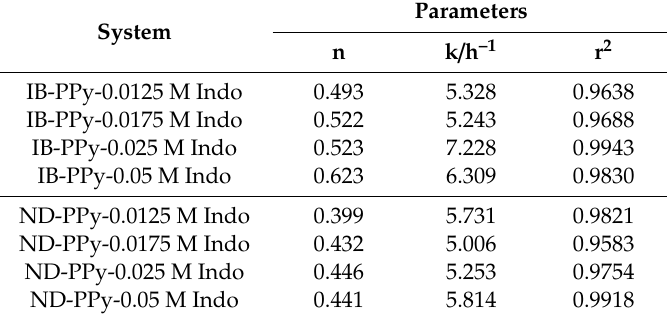
Table 5. Results of curve fitting using Equation (1) of indomethacin release data from di ff erent PPy-Indo coatings electrosynthesized on IB and ND alloy substrates using ILM-ACN based electrolyte containing 0.5 M Py and various Indo